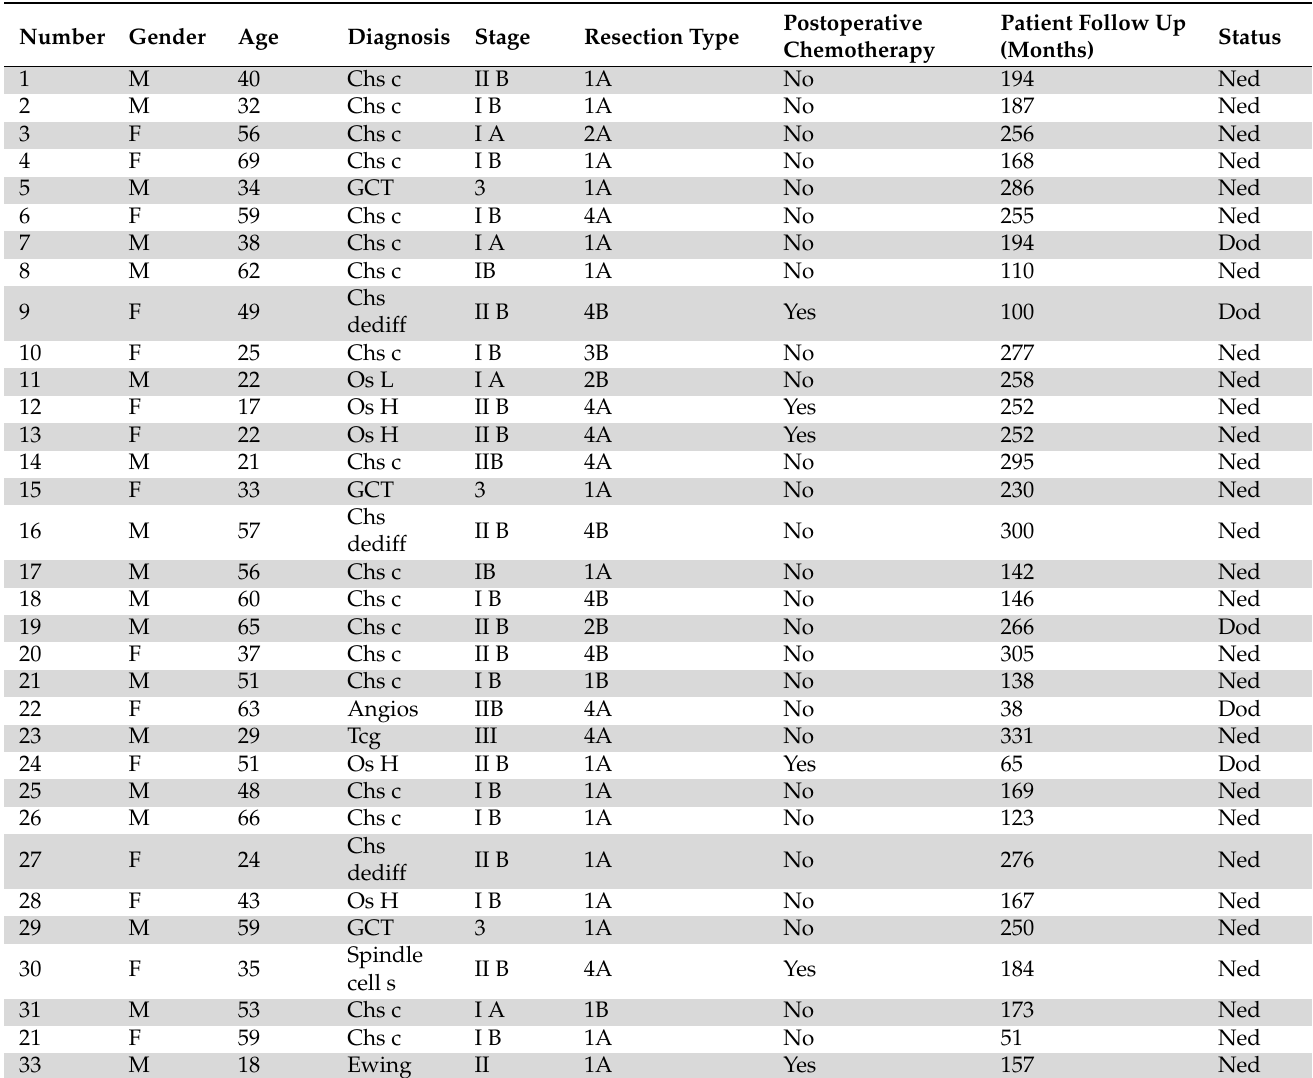
Table 2. Data on the 33 patients of the study. Chs c = central chondrosarcoma; Chs dediff = dedifferenti- ated chondrosarcoma; GCT = giant cells tumour; Os L = low grade osteosarcoma; Os H = high grade osteosarcoma; Spindle cell s = spindle cell sarcoma; Ewimg = Ewing sarcoma; Angios = angiosarcoma; Dod = dead of disease; Ned = no evidence of